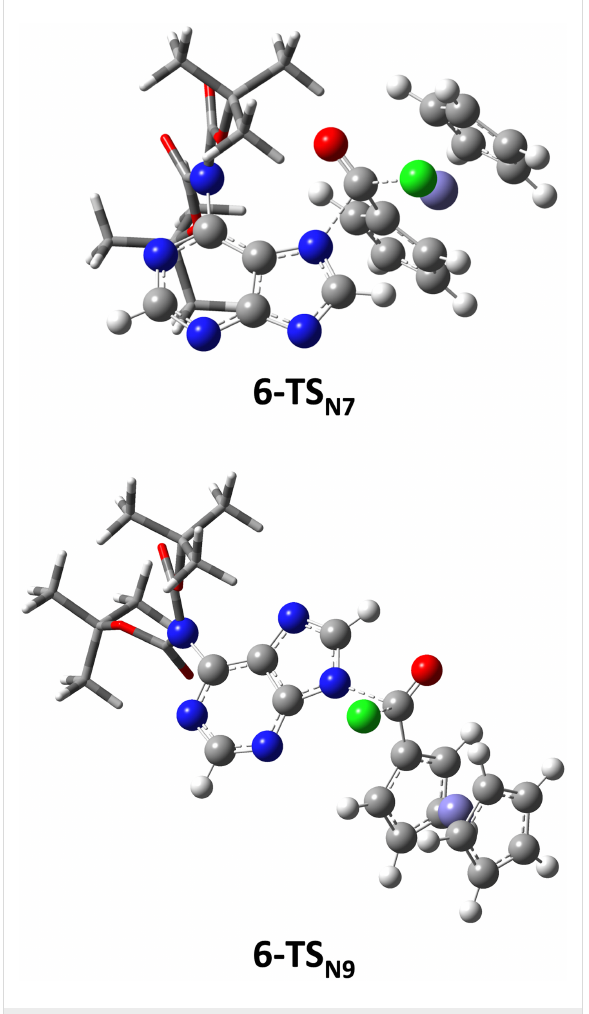
Figure 4: B3LYP/6-31+G(d)/SDD optimized transition state structures for N 7- ( 6-TS N7 ) and N 9-ferrocenoylation ( 6-TS N9 ) of the adenine anion 6 . Two bulky tert -butyloxycarbonyl groups are displayed in the tube mode for